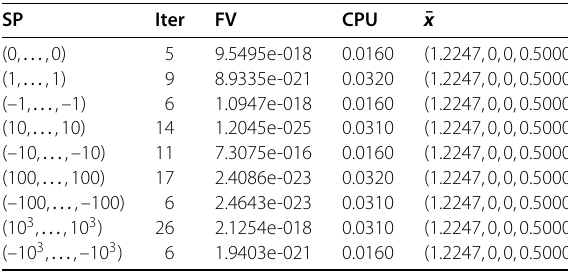
Table 5 Numerical results for Example 5